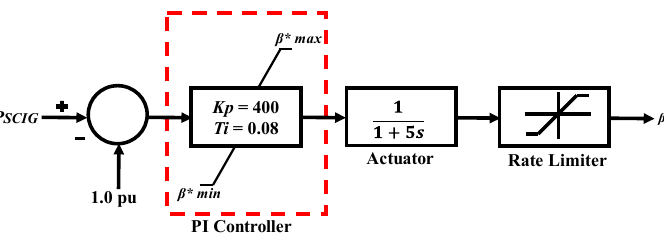
Figure 7. Pitch controller of fixed speed wind turbine-squirrel cage induction generator (FSWT-SCIG).